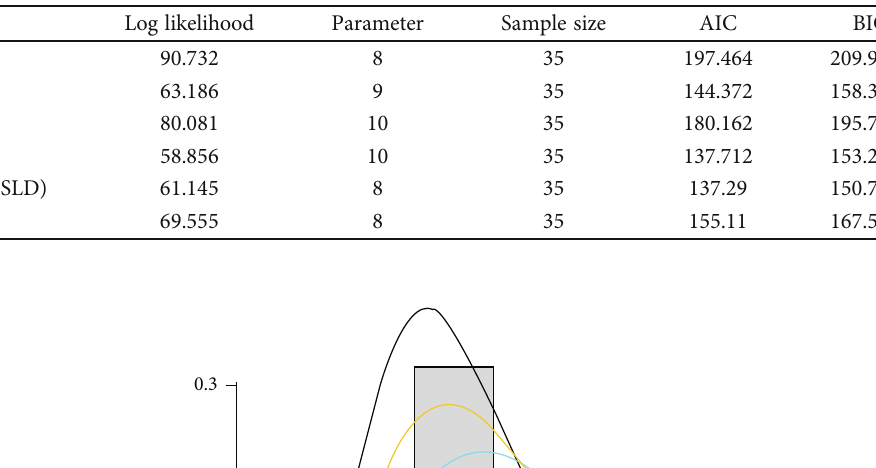
Table 4: Probability distributions and performance